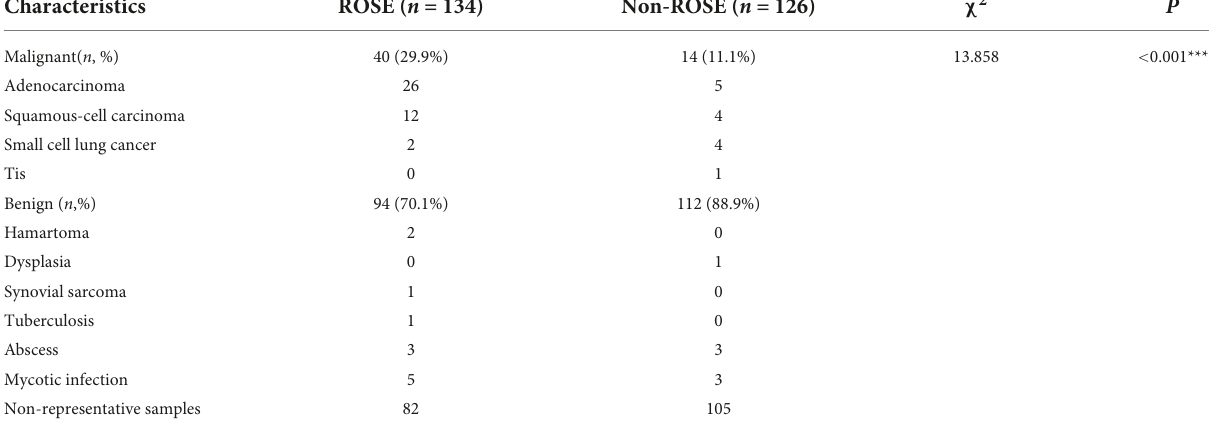
TABLE 3 Preliminary diagnosis and classification of benign and malignant diseases by using the method of ROSE during EBUS-TBNA.